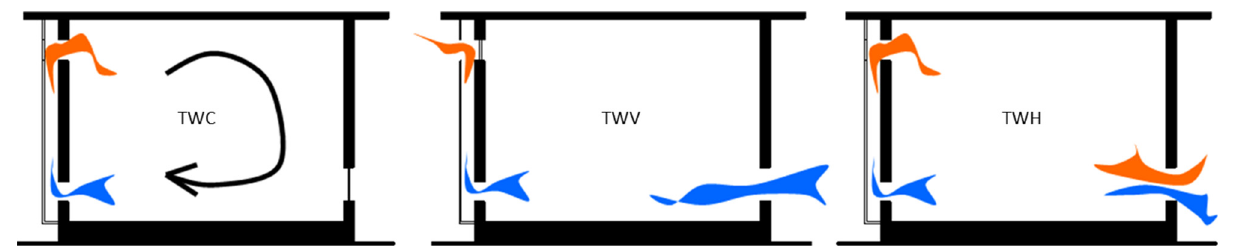
Fig. 4. Tipology of digital